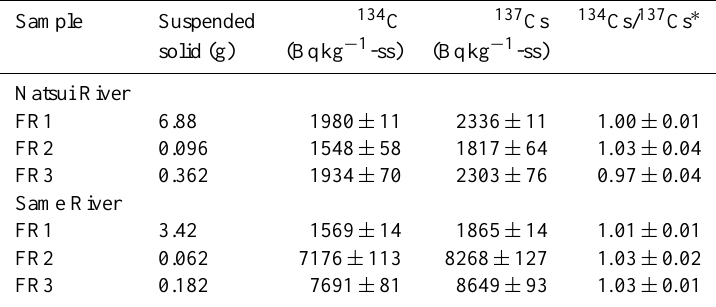
Table 3. Radioactivity of 134 Cs and 137 Cs of suspended solids in water samples from the Natsui River and the Same River collected on 22 September 2011 after Typhoon Roke.